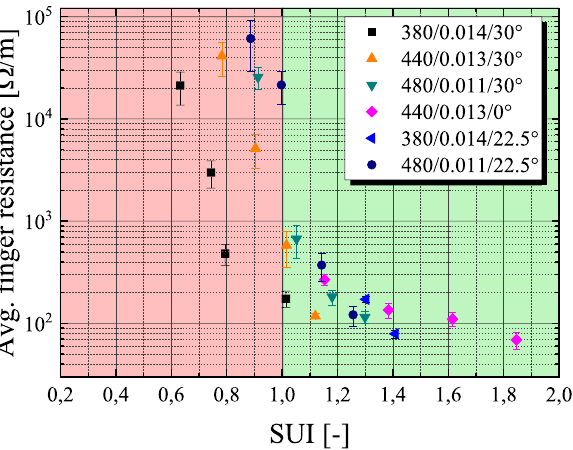
Figure 4. Correlation of the average finger resistance on the SUI value. The predicted change of printability at a SUI = 1 is supported by experimental data. For values where SU I < 1 applies, the underlying mesh will have an over proportional negative influence on the printing performance. On the other hand, for values where SUI > 1 applies, the mesh will not limit the paste transfer more than natural limitation of the screen opening channel w n . Different screens are plotted for 24 µm, 21 µm, 18 µm and 15 µm screen openings. The data is taken from our previous publication 4 . Values for the 380/0.014/22.5° screen are taken from 3